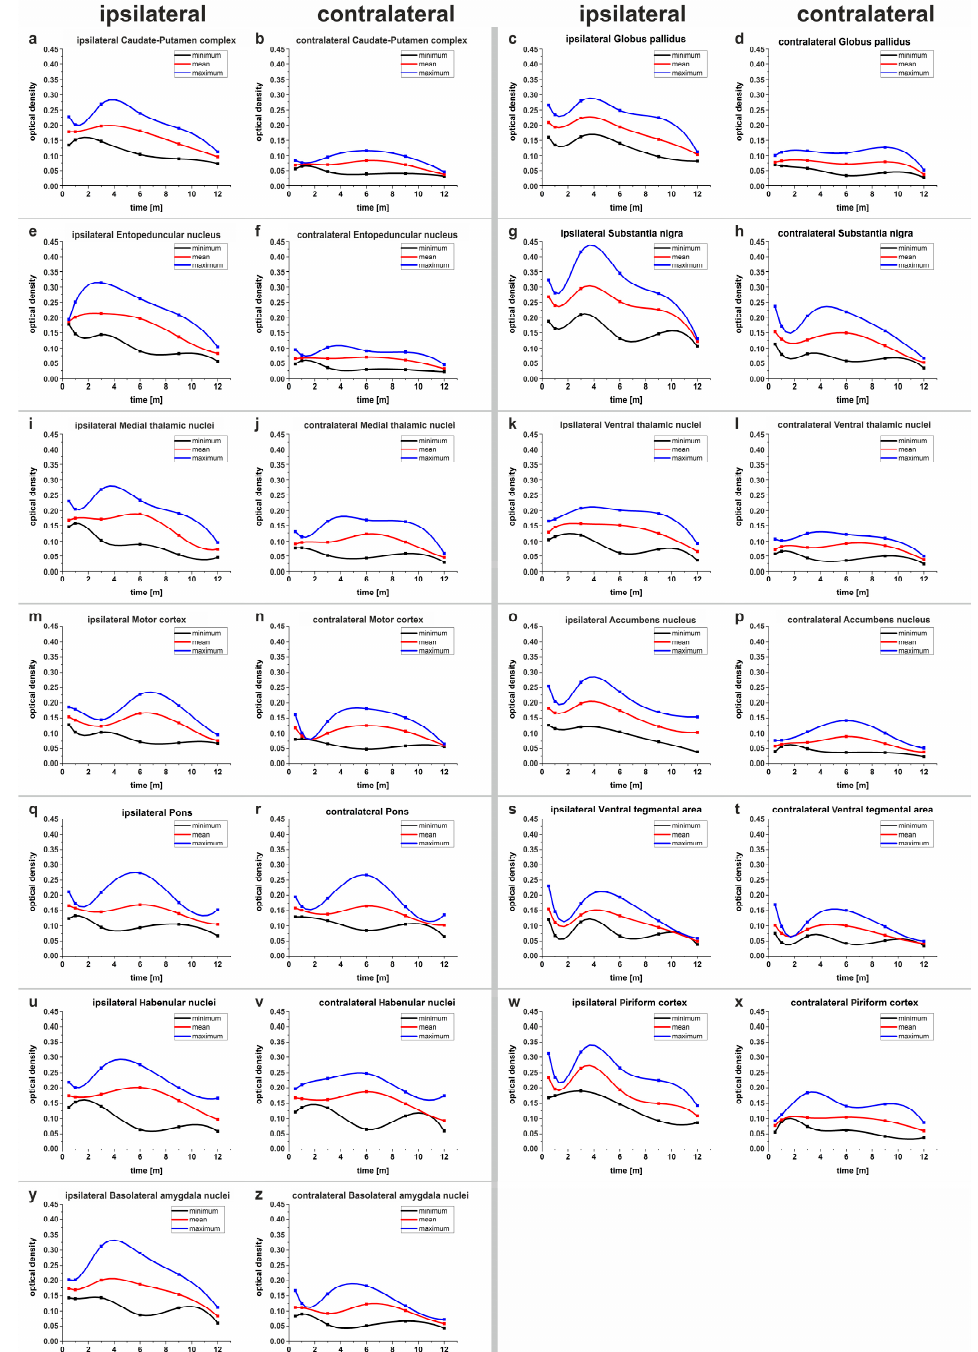
Figure 6. The diagrams show the course of the ODs over time in the course of the experiment for the investigated nuclei or brain areas of each side. Three curves are plotted in each diagram. The red curve shows the course of the mean optical density. The blue curve shows the course of the measured maximum values of the OD at one point in time. The black curve shows the course of the measured minimum values of the OD at one point in time. The curves were generated from the measured values by cubic-spine interpolation using the program Origin ® . The diagrams for the brain areas ipsilateral to the BoNT-A treatment are shown in the first and third columns, and the corresponding diagrams for the contralateral (untreated) side in the second and fourth columns. The extrapolated curves for the development of minimum measured OD, mean OD, and maximum measured OD are shown for brain parts ipsilateral to the injection site and contralateral to the injection site in